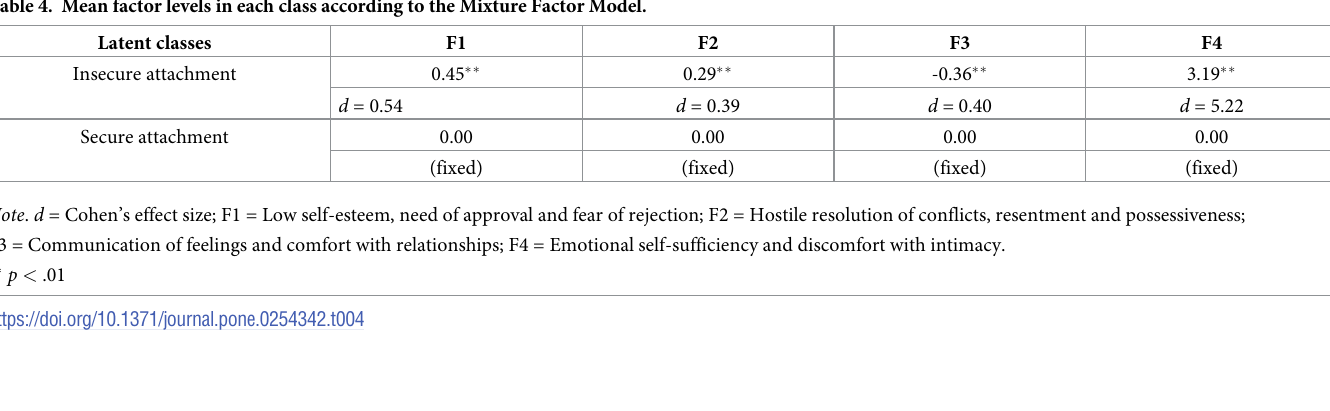
Note . Criteria: Bayesian Information Criterion (BIC), Entropy value ( Δ ), Lo-Mendel-Rubin (LMR) difference test with associated probability.